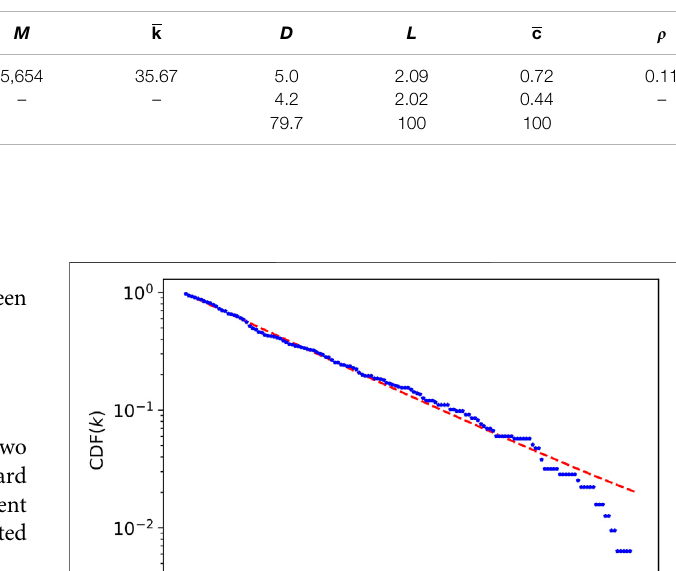
TABLE 2 | Comparison of network properties between the co-investment network and randomized networks.